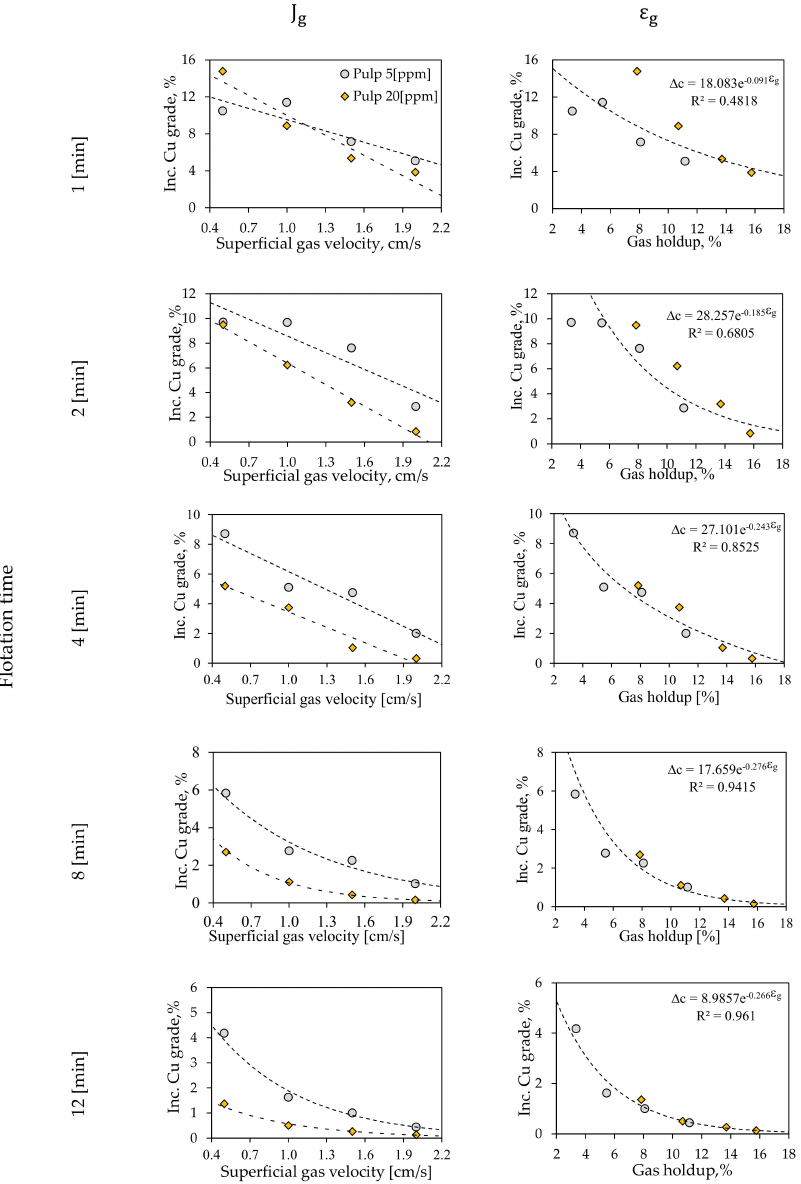
Figure 14. Incremental Copper grade for batch flotation times as a function of superficial gas velocity (first column) and gas holdup (second